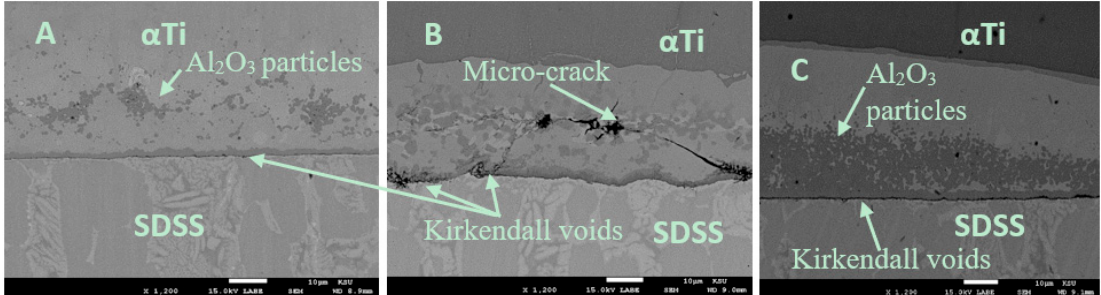
Figure 3. Effect of bonding time on the joint zone during diffusion bonding of Ti–6Al–4V and SDSS Figure 3. E ff ect of bonding time on the joint zone during di ff usion bonding of Ti–6Al–4V and SDSS using a Cu/Al 2 O 3 interlayer. Each sample was bonded at 850 °C for ( A ) 30 min, ( B ) 45 min, or ( C ) 60 using a Cu / Al 2 O 3 interlayer. Each sample was bonded at 850 ◦ C for ( A ) 30 min, ( B ) 45 min, or ( C ) 60 min.